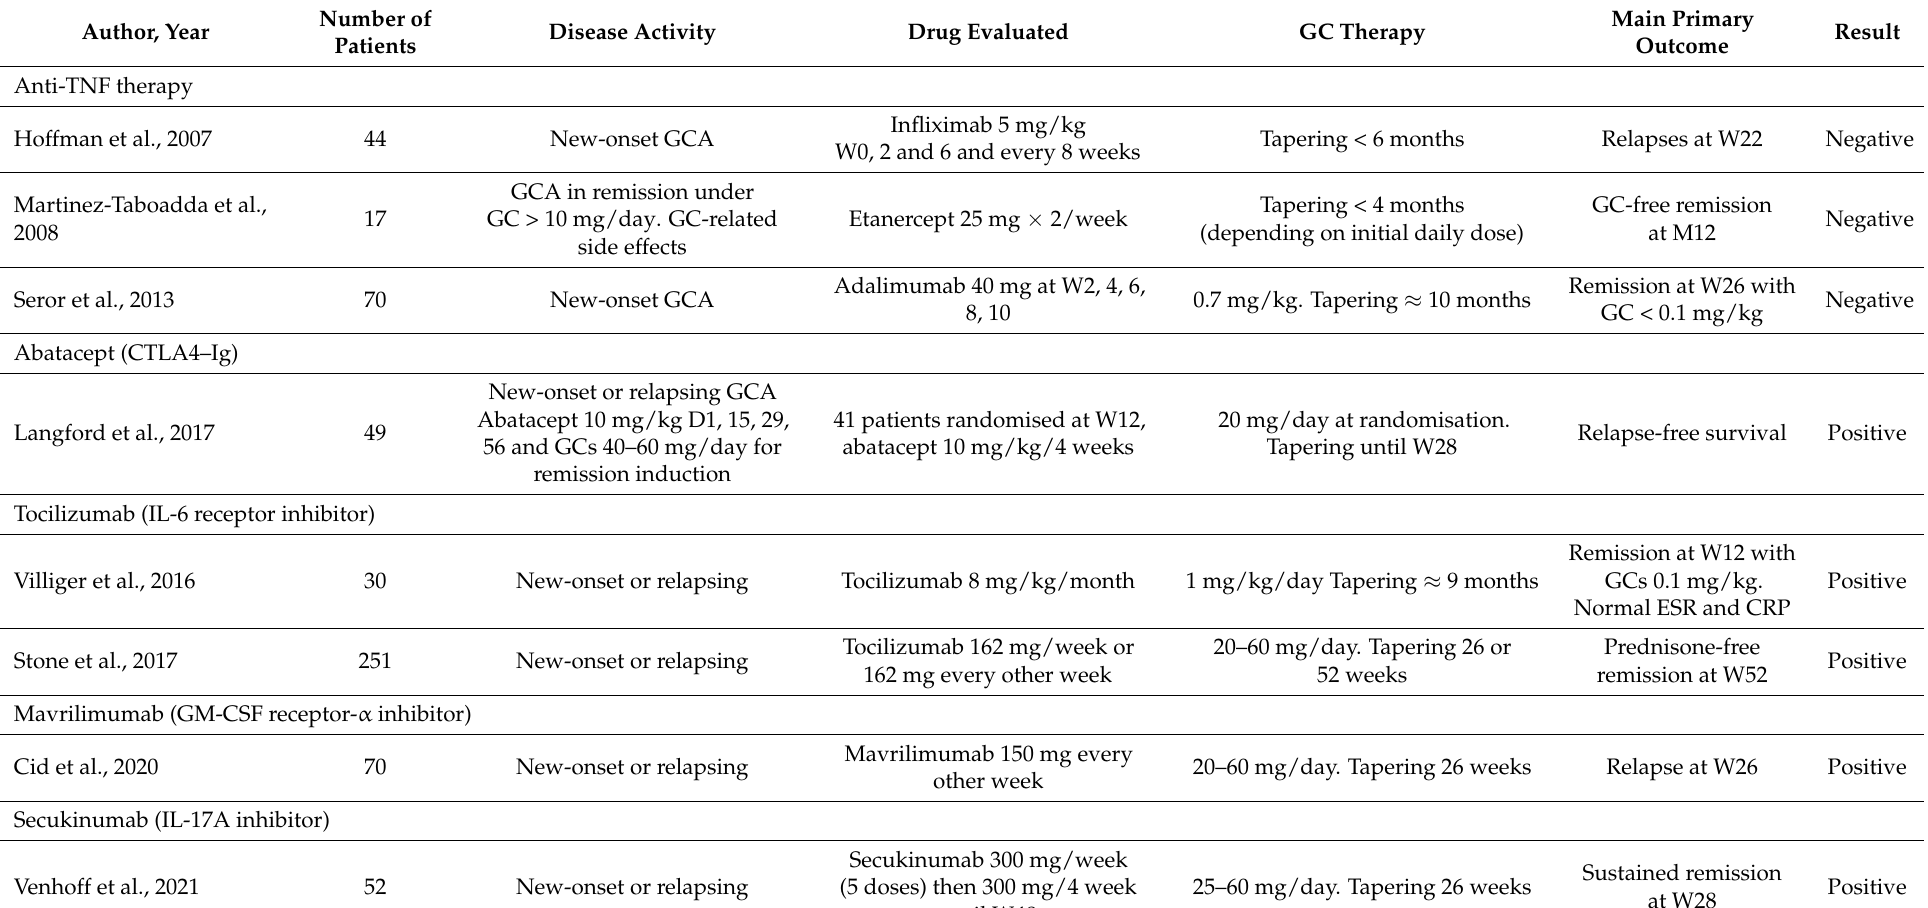
Table 2. Results of randomised controlled trials evaluating biologics during